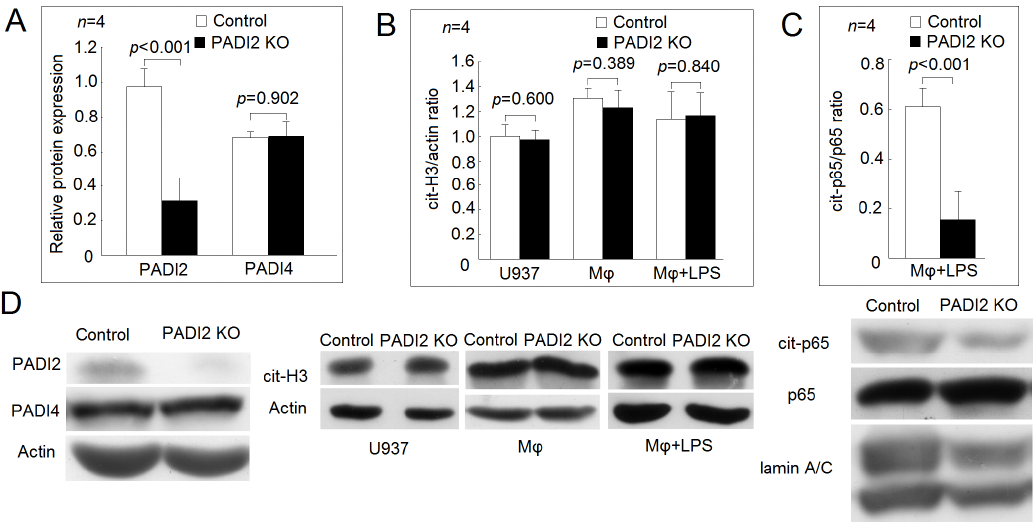
Figure 1. Validation of peptidylarginine deiminase 2 (PADI2) knockout U937 cells and their